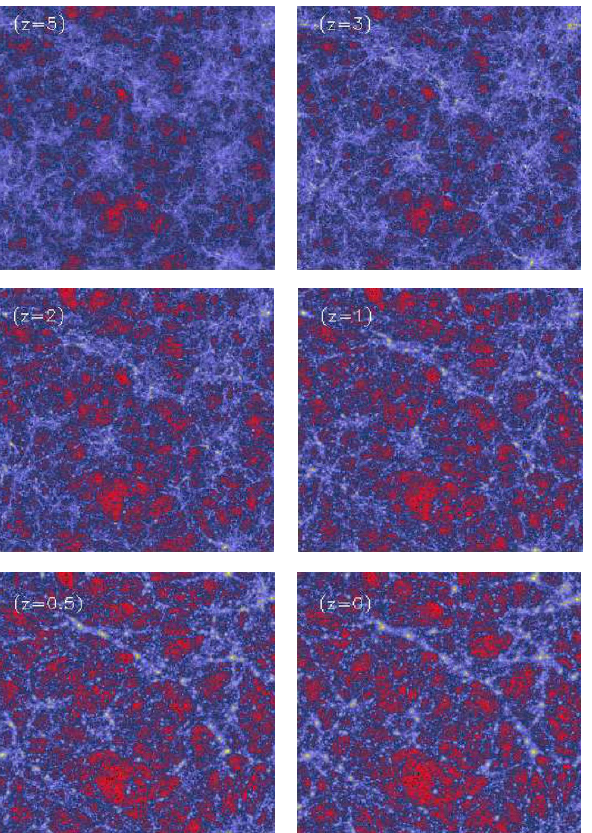
Figure 14: Λ -CDM simulation at di ff erent redshifts.